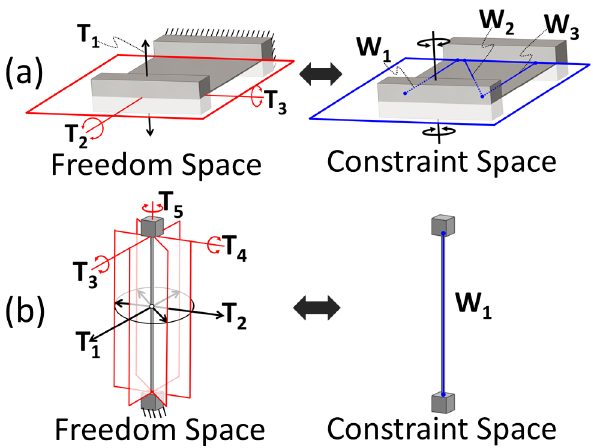
Figure 4. Freedom and constraint spaces for two flexure elements—blade and wire flexure 3 – blade and wire 4